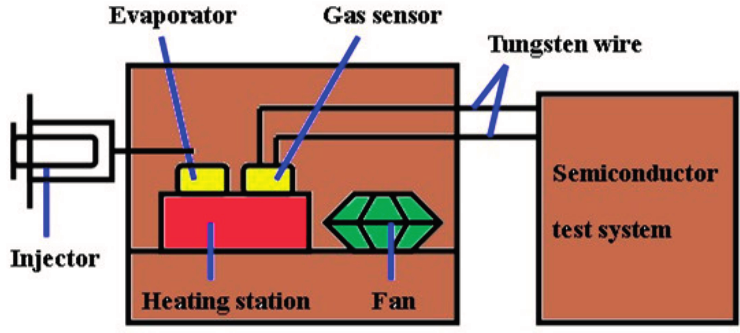
Figure 1. Schematic diagram of the test